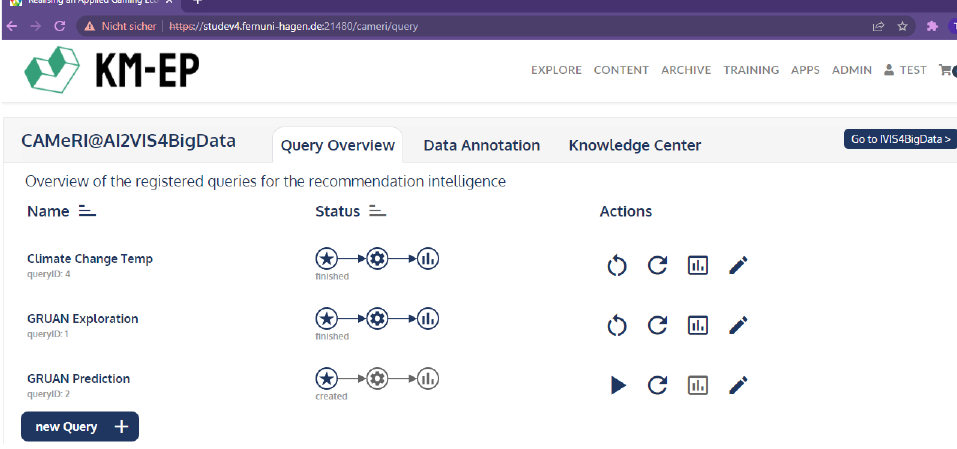
Figure 15. Query overview for executed